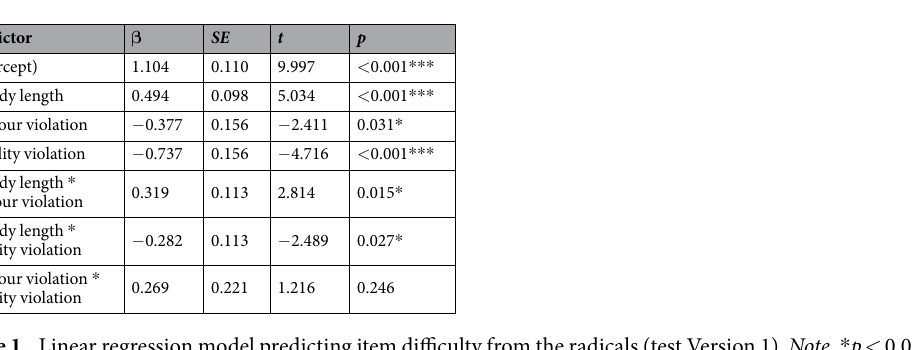
Table 1. Linear regression model predicting item difficulty from the radicals (test Version 1). Note . * p < 0.05. *** p < 0.001. Regression coefficients are standardised.